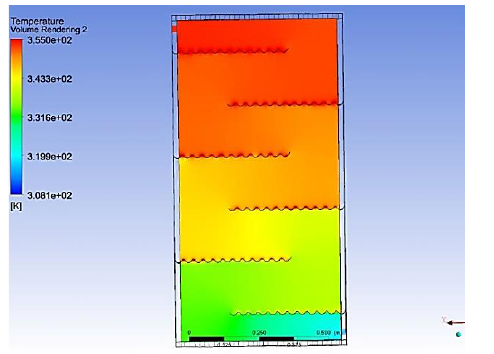
Figure 3. Performance prediction of an air-flow distribution pattern using CFD for the SAH. (e x = 10 x )